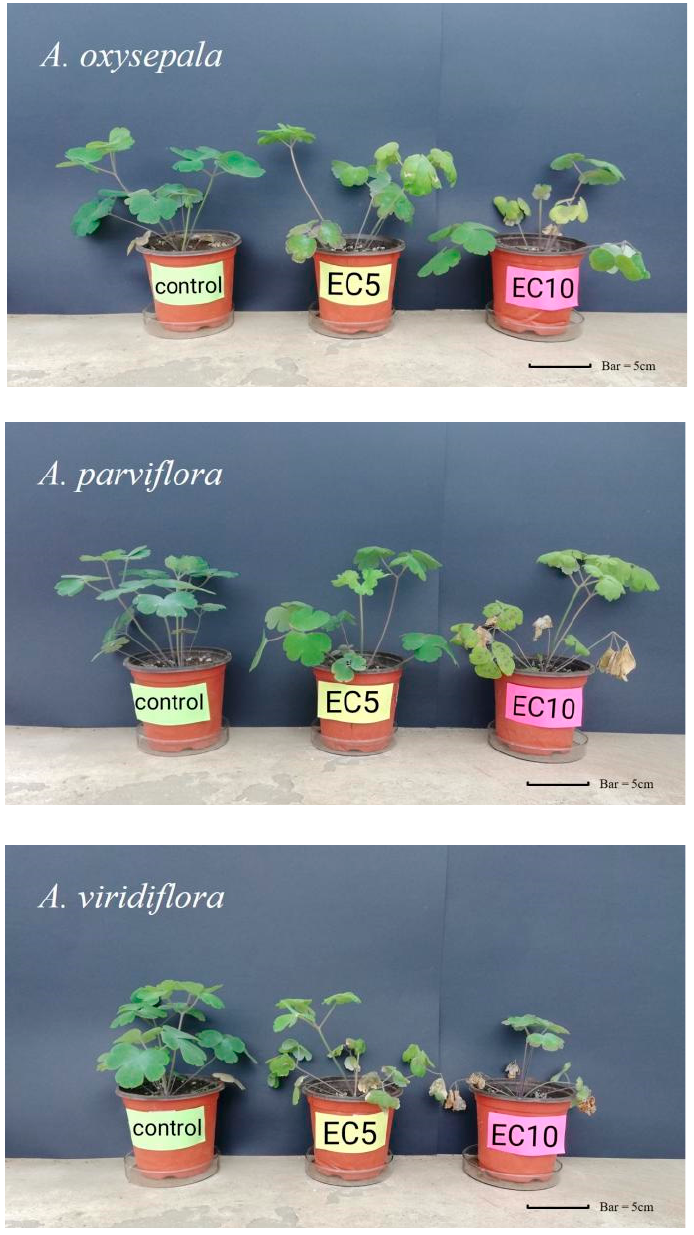
Figure 3. A. oxysepala , A. parviflora , and A. viridiflora irrigated with tap water (control) and salt solution at an electrical conductivity (EC) of 5 dS · m − 1 (EC 5) and 10 dS · m − 1 (EC 10) after 8 times. The shoot DW was significantly affected by salt treatments (Table 7). Both treatments and species had an extremely significant impact on all DWs. In EC10, the shoot DWs of A. oxysepala , A. parviflora , and A. viridiflora were reduced by 29.2%, 44.4%, and 37.4%, respectively, compared to those in the control. In EC10, the root DWs of A. oxysepala , A. parviflora , and A. viridiflora were reduced by 78.9%, 87.3%, and 83.6%, respectively, com- pared to those in the control (Table 7). In EC10, the total DWs of A. oxysepala , A. parviflora